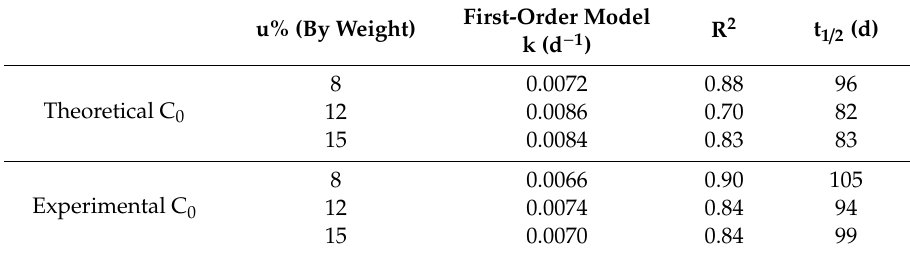
Table 6. First-order reaction rate constants and half-life times for microcosms with C / N = 180. u% (By Weight)